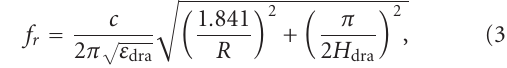
properties. The resonant frequency can be determined with the perfect magnetic conductor (PMC) wall